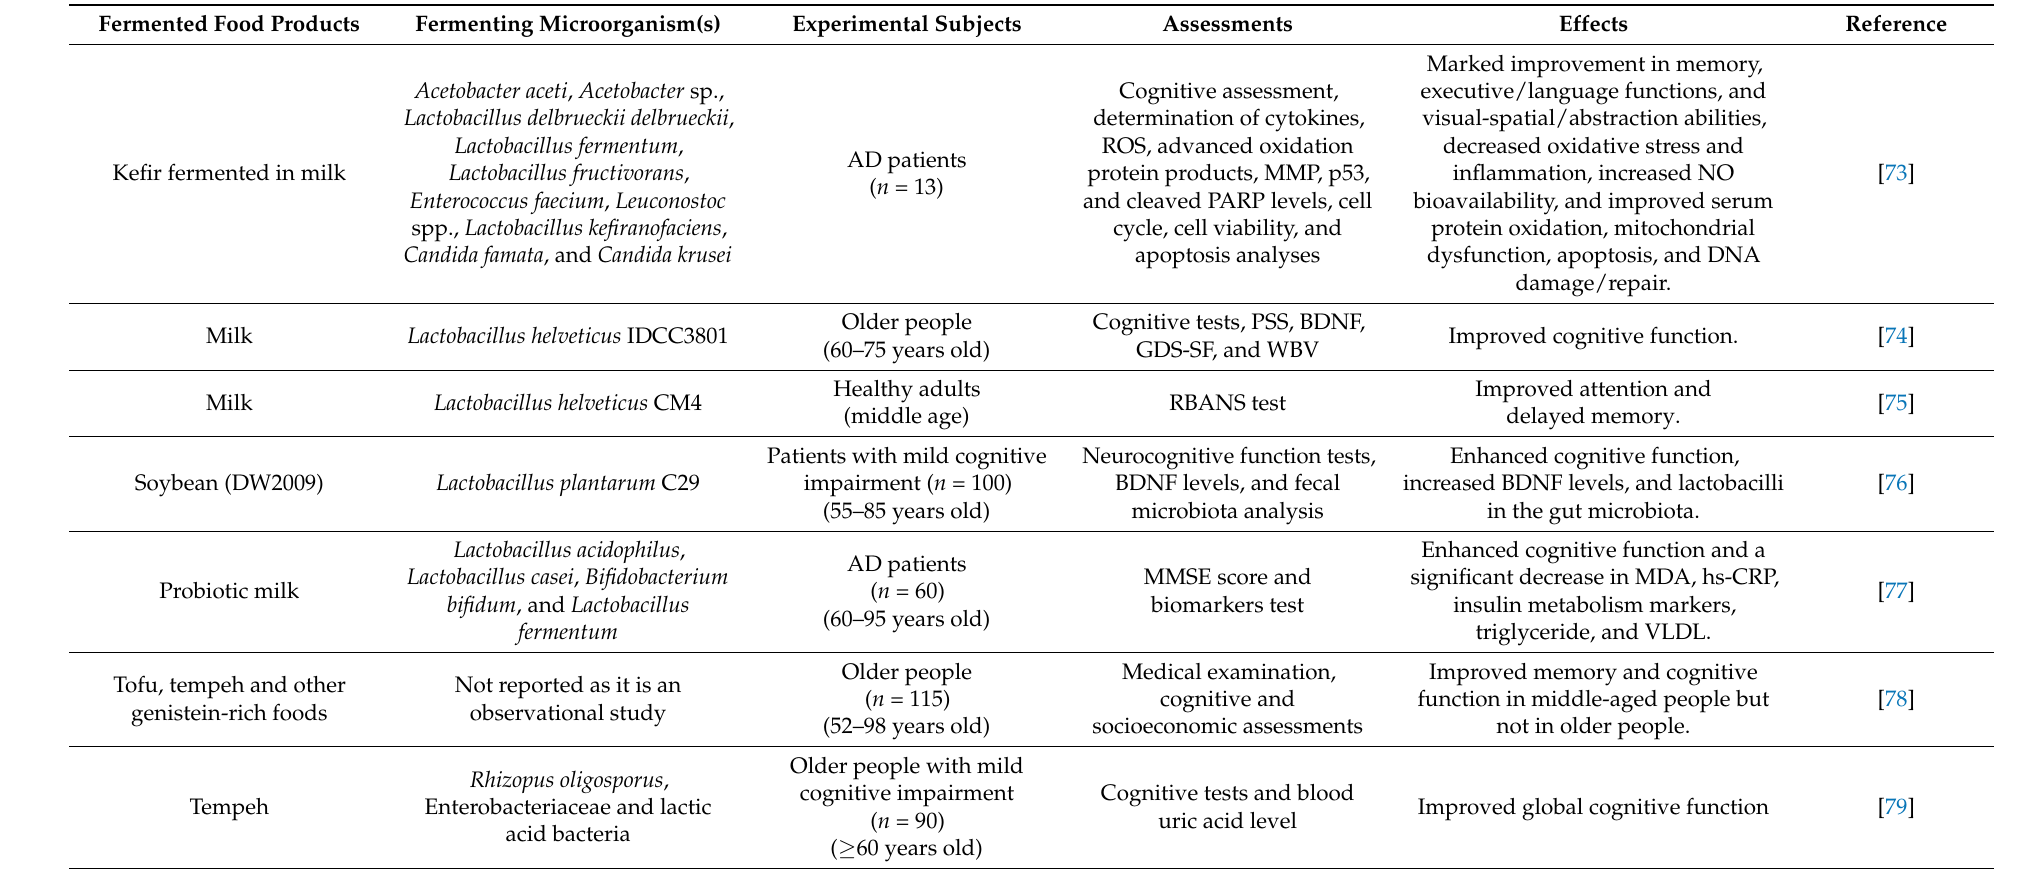
Table 2. Clinical studies of fermented foods and their effects on